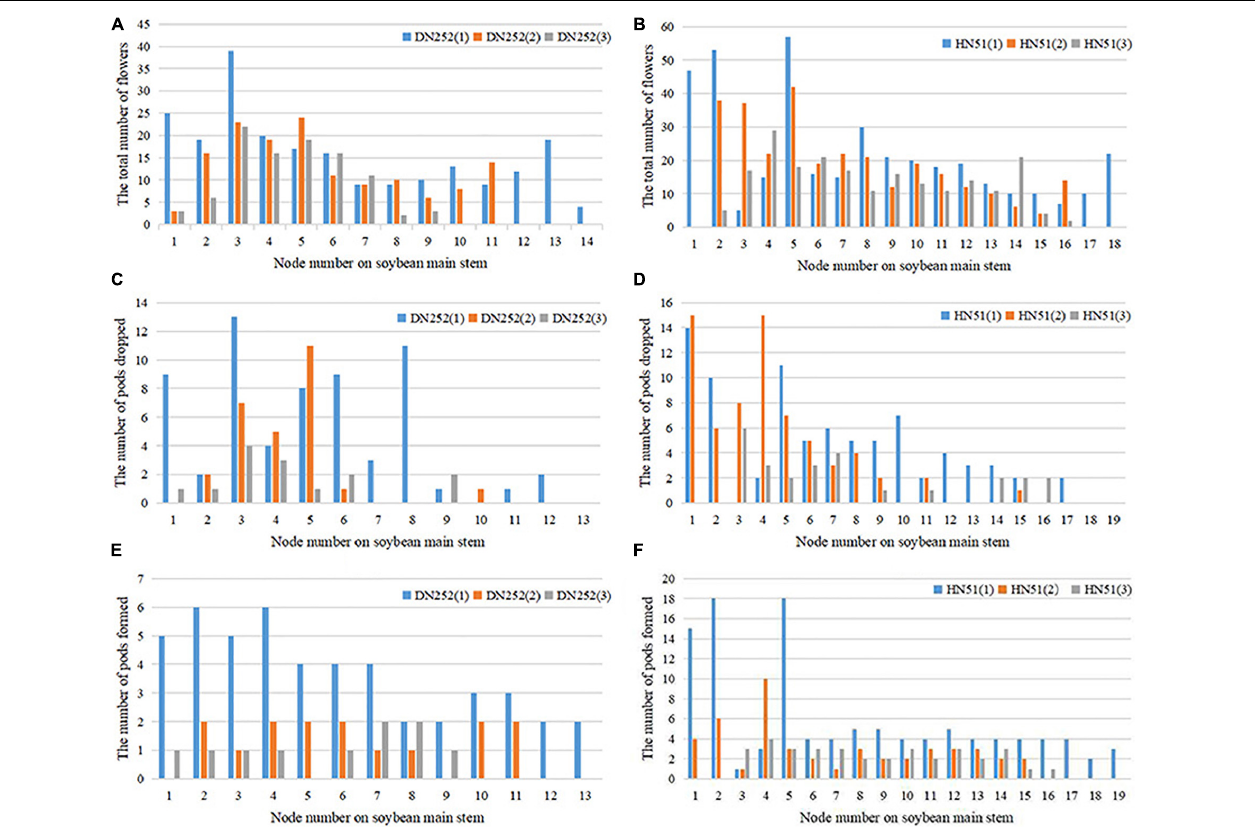
FIGURE 7 | Distribution of total flowers number, number of pods dropped, and number of pods formed at the main stem nodes of the two cultivars DN252 and HN51. (A) Distribution of the total number of flowers at the main stem nodes of the DN252 variety. (B) Distribution of the total number of flowers at the main stem nodes of variety HN51. (C) Distribution of the number of pods dropped at the main stem node of variety DN252. (D) Distribution of the number of pods dropped at the main stem node of variety HN51. (E) Distribution of the number of pods formed at the main stem node of variety DN252. (F) Distribution of the number of pods formed at the main stem nodes of variety HN51. TABLE 6 | The flower drop rate at different reproductive